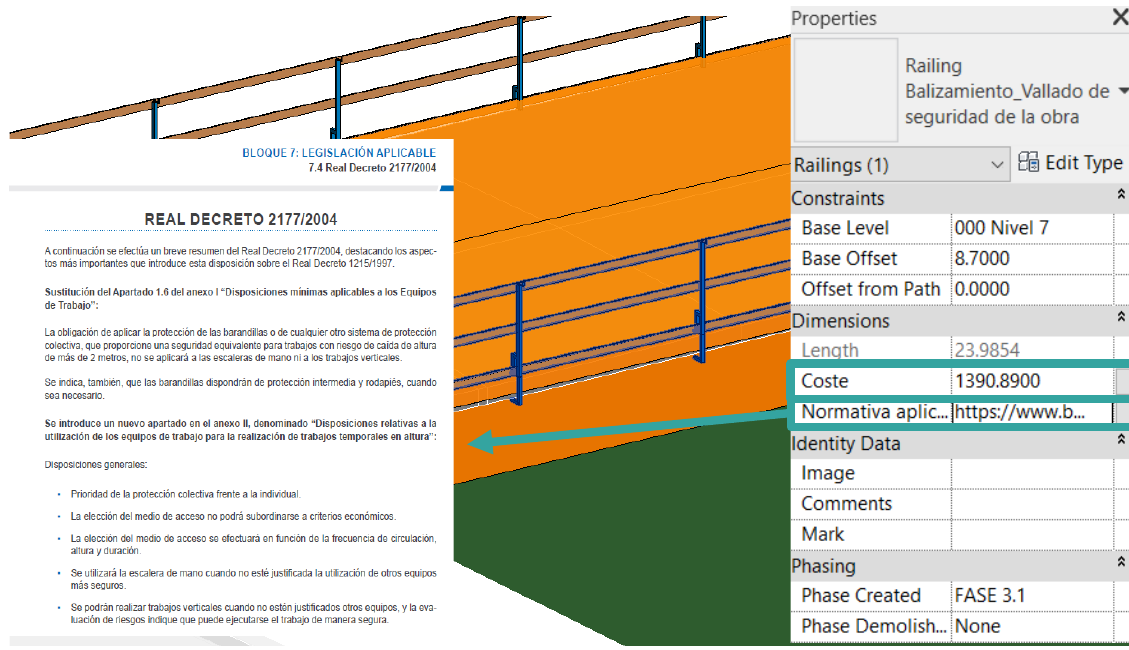
Figure 11. Plan with information on the risk areas, evaluation and collective protection measures.